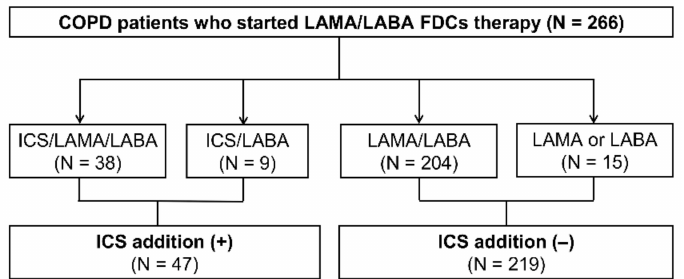
Figure 1. Treatment evolution after initiation of LAMA / LABA fixed-dose combinations therapy. CAT, COPD assessment test; FDC, fixed-dose combinations; ICS, inhaled corticosteroids; LABA, long-acting beta2-agonist; LAMA, long-acting muscarinic